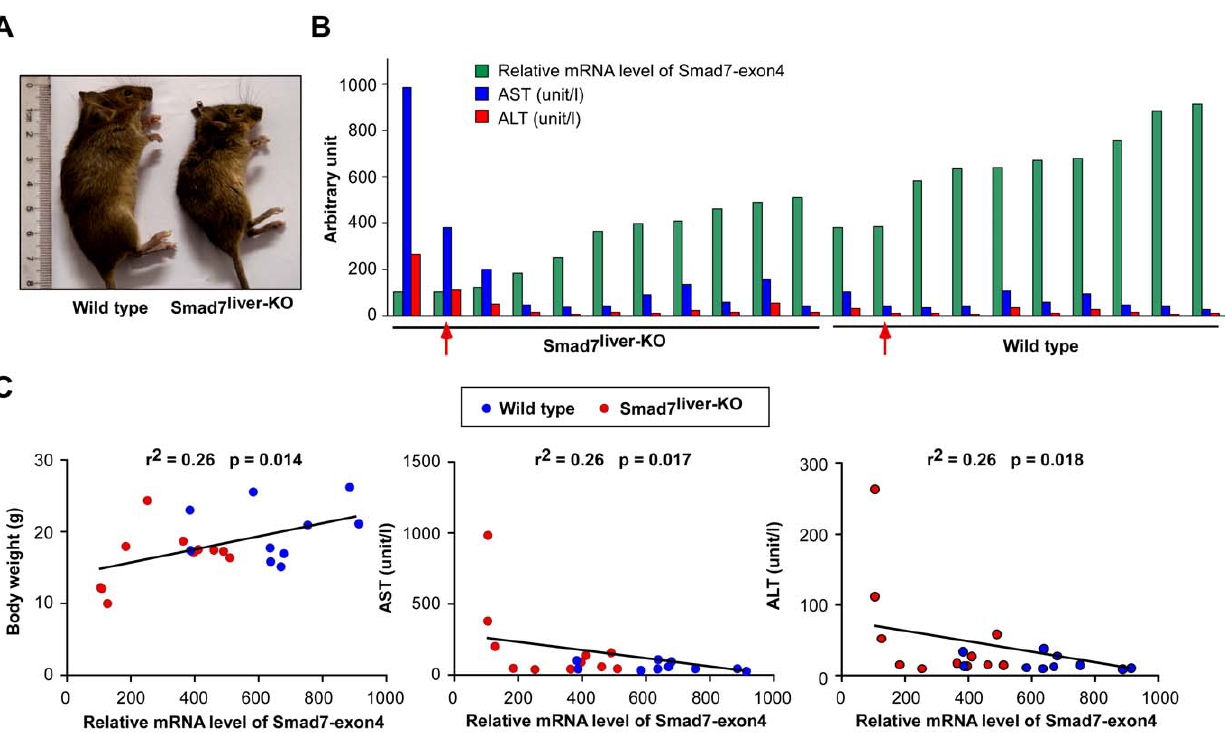
Figure 2. Deletion of Smad7 causes spontaneous liver failure. (A) Representative images of 12-week-old wild type and Smad7 liver-KO mice. (B) Relative mRNA level of Smad7 exon4 (green) as comparison with the serum AST (blue) and ALT (red) values. The arrows indicate the mice that were used in histological and immunohistochemical analyses performed in Figure 3. (C) Correlation analyses of body weight, AST and ALT levels with the mRNA level of Smad7 exon4. The values of body weight, AST and ALT values were plotted against the relative mRNA level of Smad7 exon4 for each mouse (red for Smad7 liver-KO mice and blue for wild type mice) and subjected to linear regression analysis. n=11 for Smad7 liver-KO and n=10 for wild type mice.